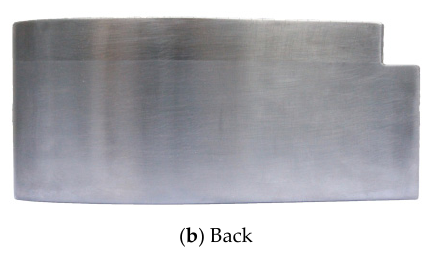
Figure 9. ( a , b ) After grinding the guide vane.